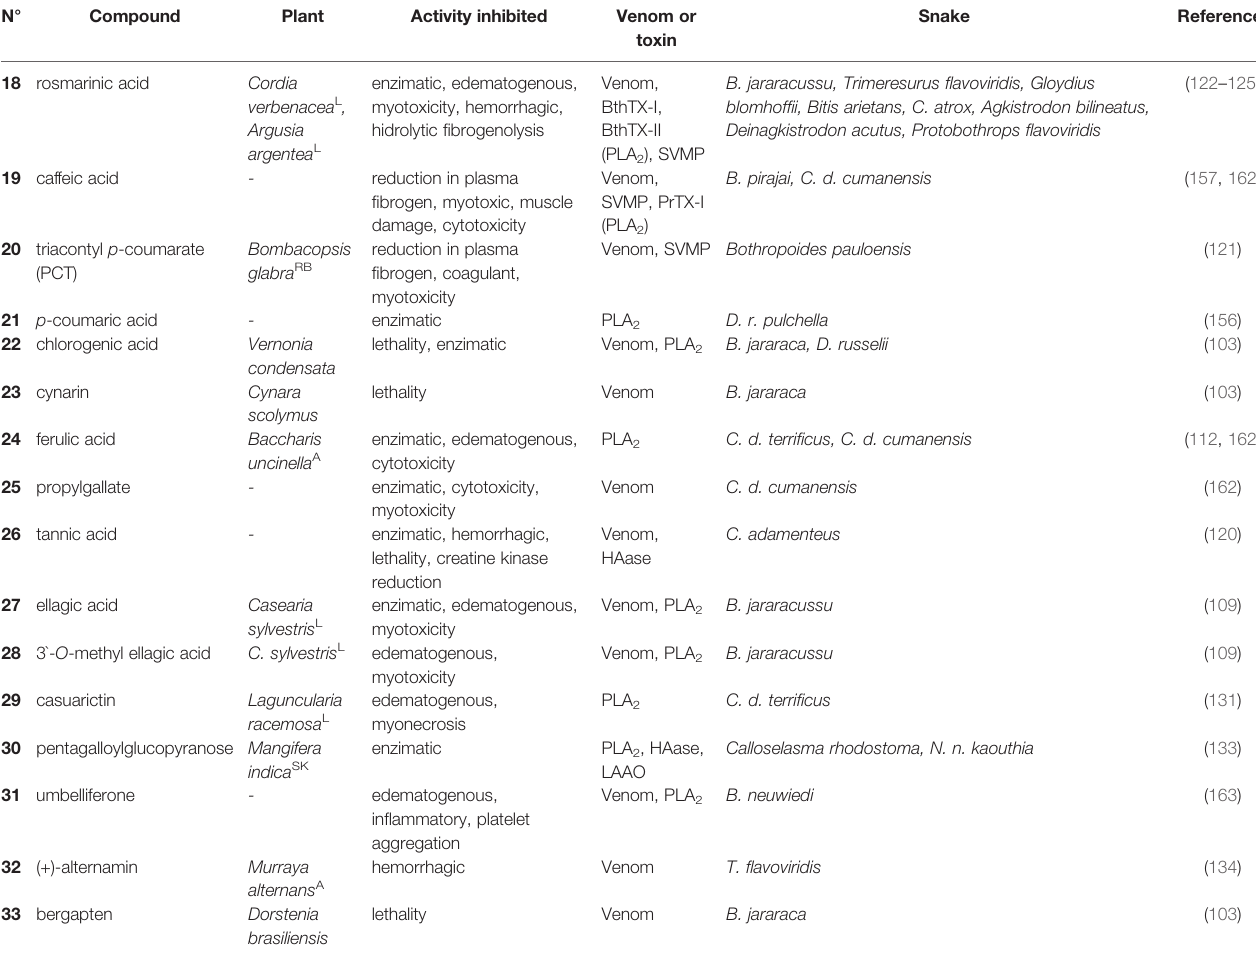
TABLE 2 | Hydroxycinnamic acids (18 – 25) and tannins (26 – 33) with antivenom